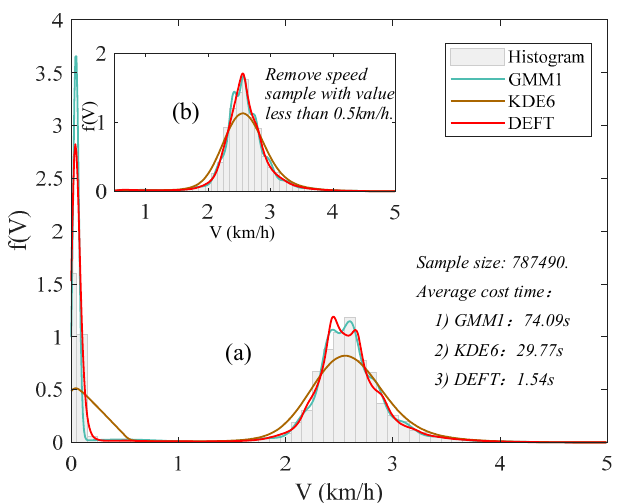
Figure 4. The fitted distributions of the speed of roller 1 in September 2018. GMM1 refers the optimal Gaussian mixture model based on Akaike’s Information Criterion [42]; KDE6 refers the kernel density estimation method with linear kernel [43]; DEFT refers to the Bayesian field theory method.